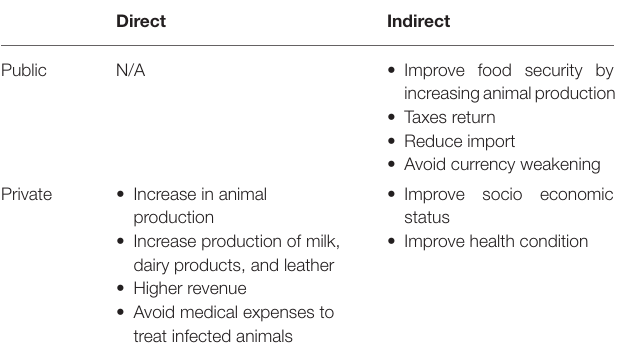
TABLE 4 | Summary of direct and indirect benefits from vaccination. Direct